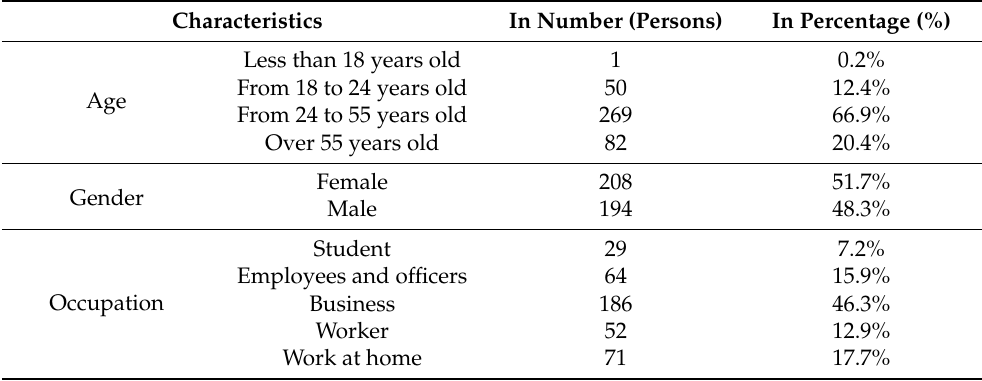
Table 2. Basic characteristics of the sample ( N =